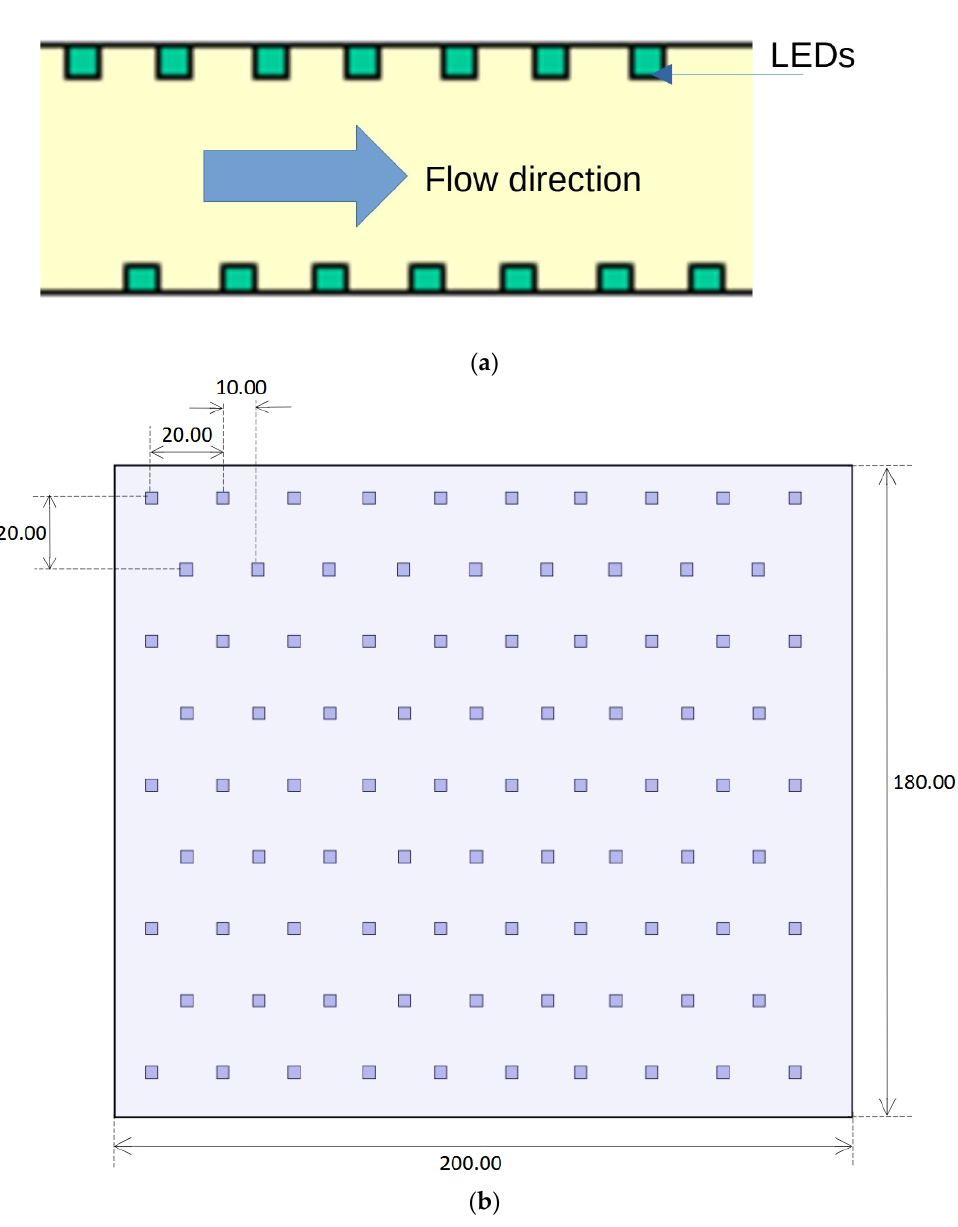
Figure 4. The UVC chamber LEDs layout where ( a ) staggering is arranged between the upper and lower LEDs arrays and ( b ) staggering is also shown in the LED array itself to reduce the number of LEDs. The length unit is mm.